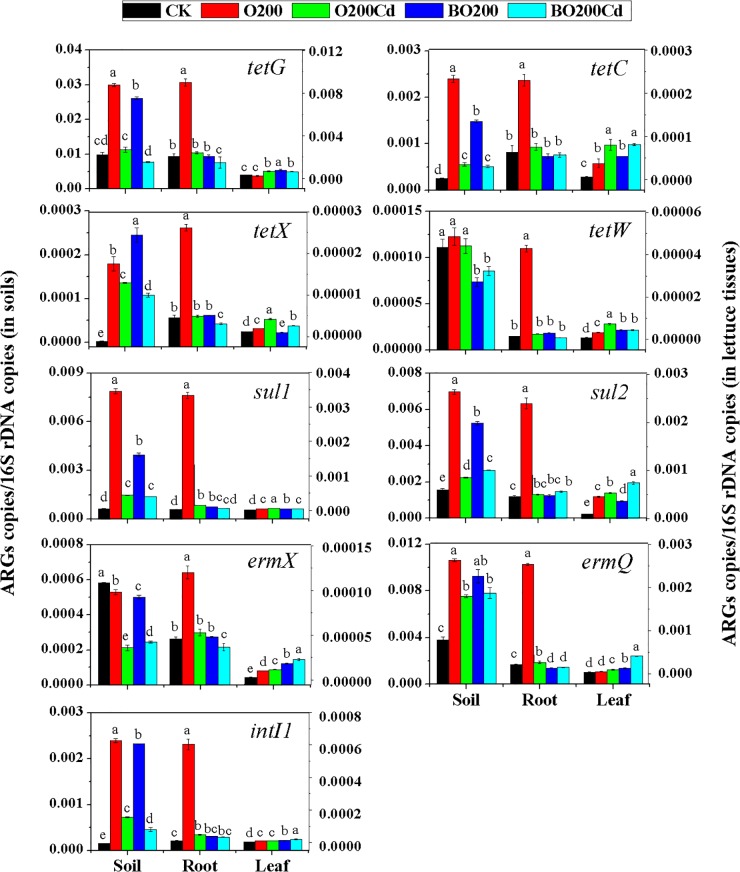
Relative abundances of ARGs in dry soil and fresh lettuce samples. Different letters within a group indicate significant differences at P < 0.05. Error bars indicate the SD based on three replicates.